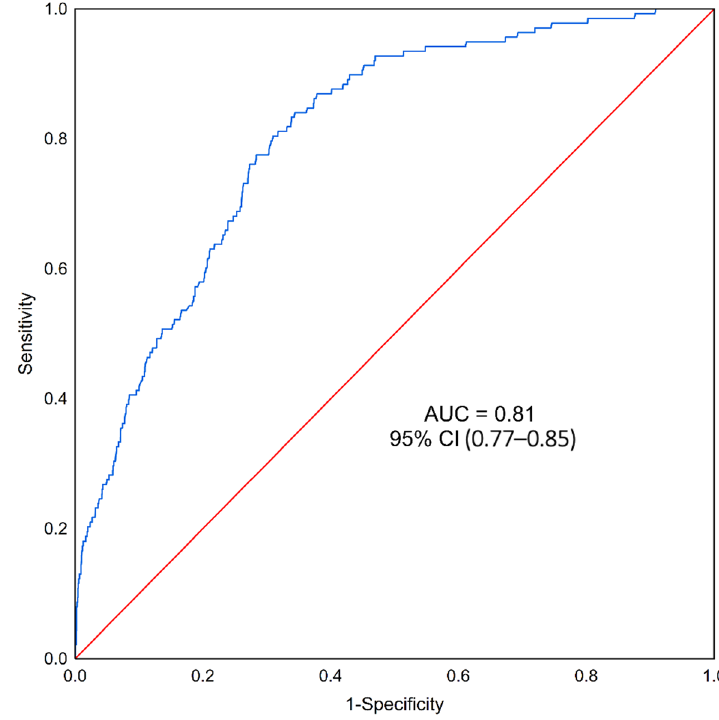
Figure 3. Multivariate logistic regression predictive model for developmental dysplasia of the hip (DDH) in children (Statistica 13.3). The blue line represents a receiver operating characteristic (ROC) curve.